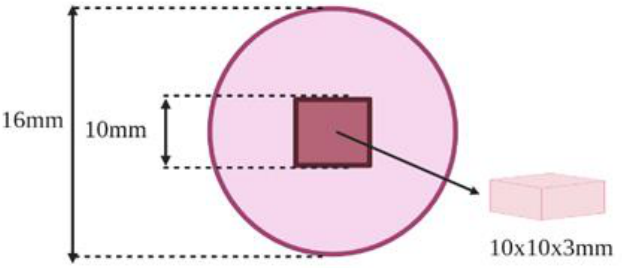
Figure 1. Illustration of the specimen (10 × 10 × 3 mm) centered in the center of resin holder (16 × 10 mm). Table 1. Summary of materials used in present study and fabrication methods.